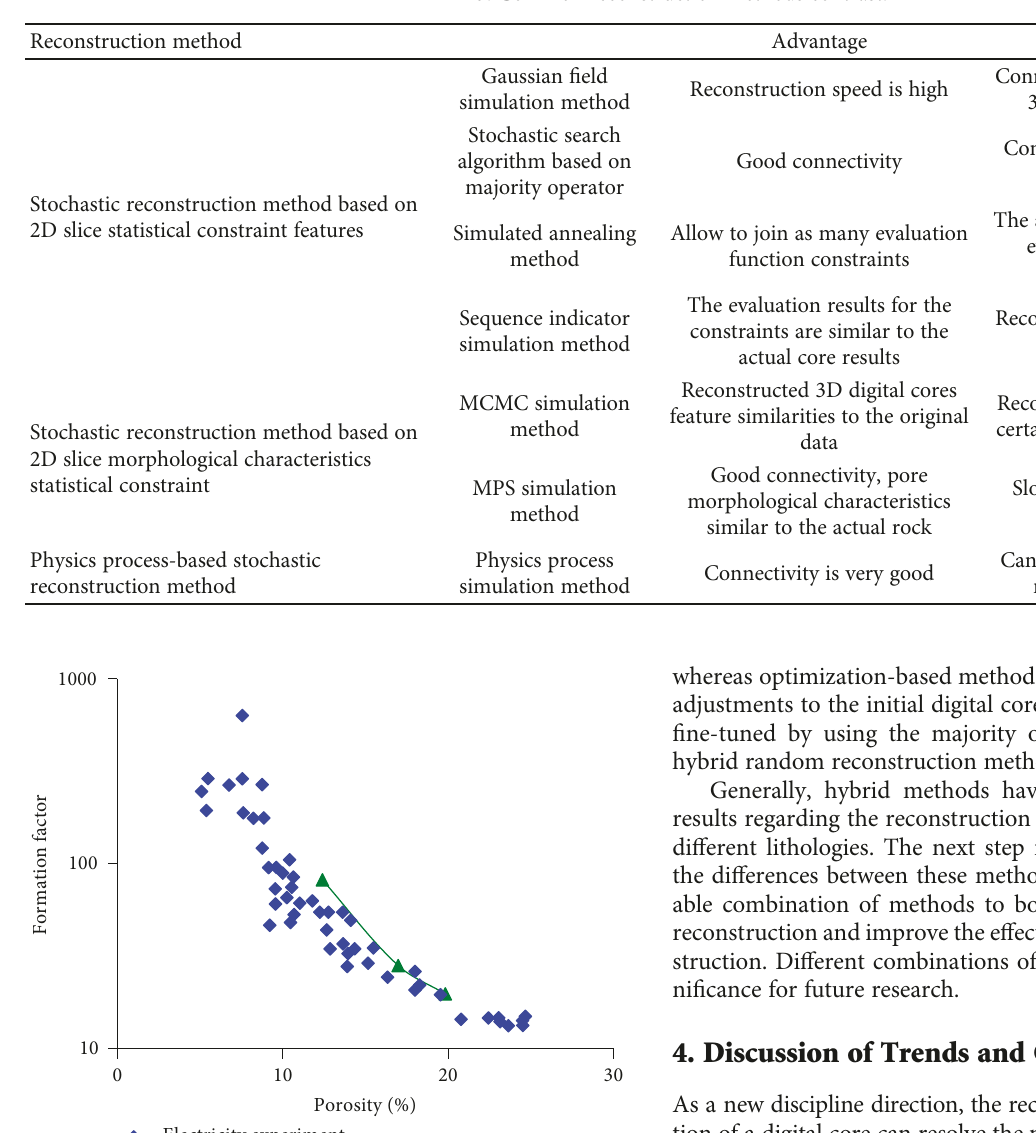
Table 3: Common reconstruction methods contrast.